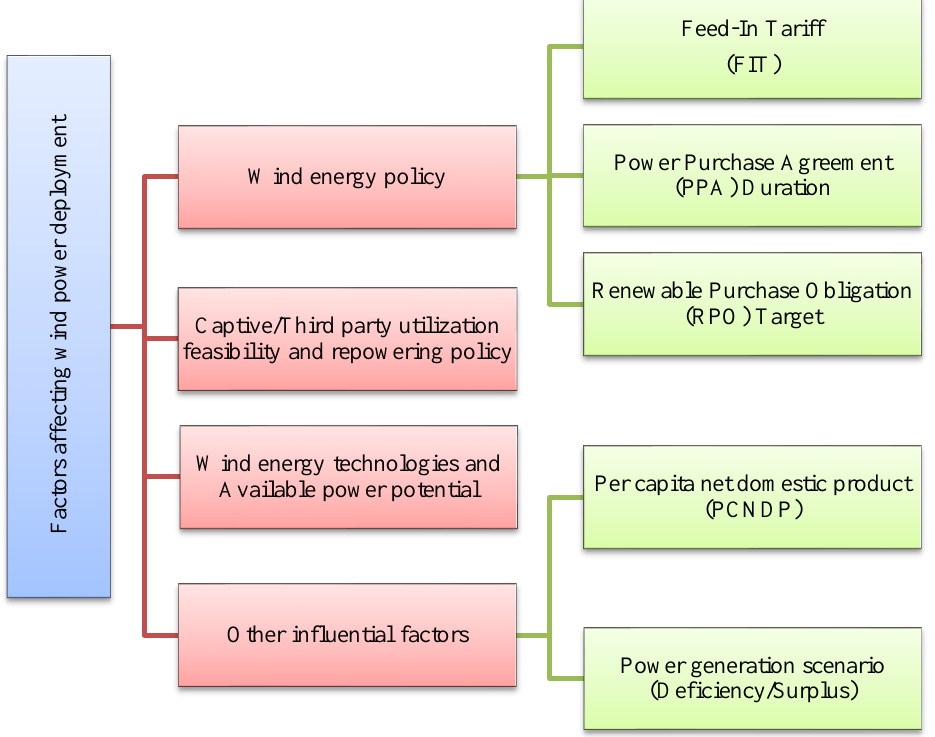
Fig. 3. Various factors affecting the wind power